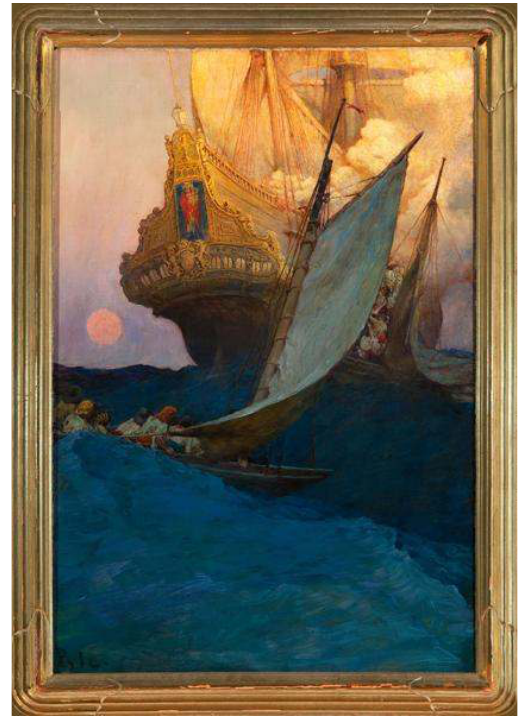
Pre-Raphaelites and Symbolist movements (Fig. 3). Figure 3. Howard Pyle, An Attack on a Galleon . Oil on canvas